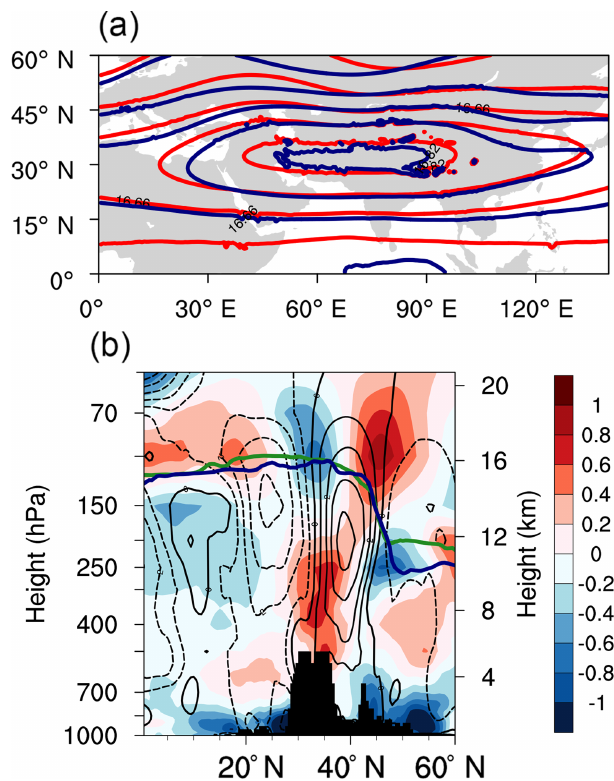
Figure 2. (a) 100hPa geopotential height (in km) in strong (weak) monsoon years during July–August is shown in red (blue). (b) Latitude–height cross section of temperature anomalies (color shaded, in K), zonal wind anomalies (contour lines, in ms − 1 ) be- tween strong and weak monsoon years (“strong” minus “weak”) and tropopause height (thick lines) in strong monsoon years (green) and weak monsoon years (blue) over the Indian subcontinent (80– 85 ◦ E) during